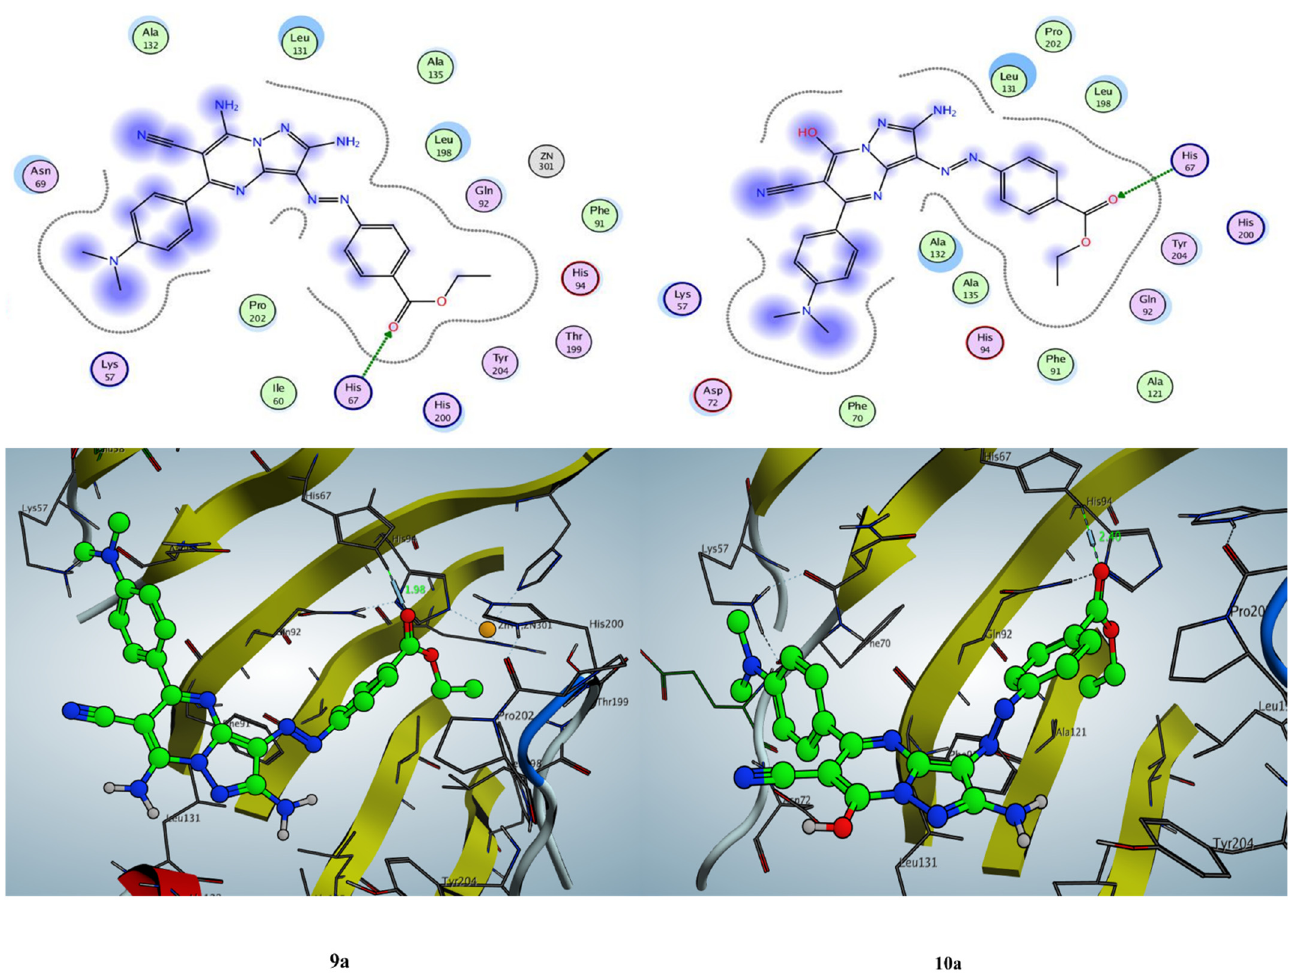
Figure 9. 2D and 3D enzyme–ligand interaction of compounds 9a and 10a inside the active site of h